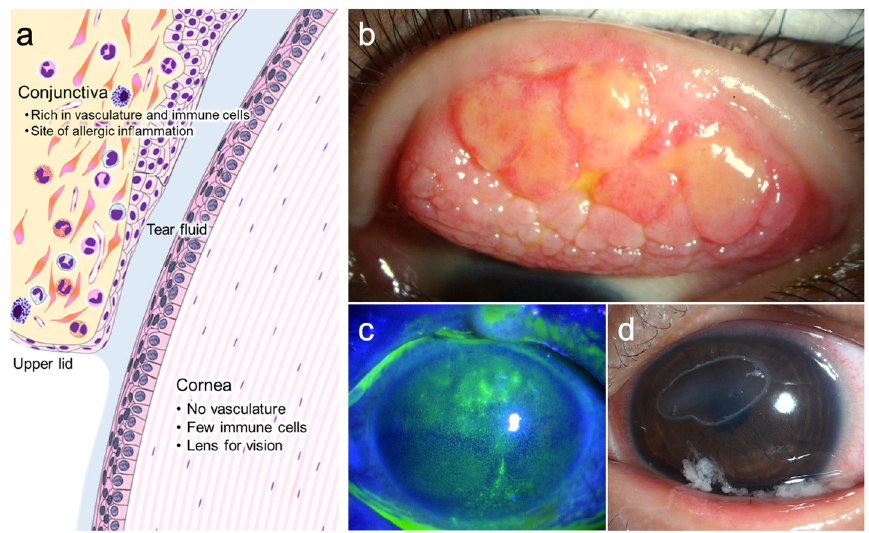
Figure 1. Anatomy of the ocular surface and clinical pictures of vernal keratoconjunctivitis (VKC). The conjunctiva and cornea lie adjacent to each other with the tear fluid ( a ). In patients with VKC, giant papillae at the upper tarsal conjunctiva ( b ) and corneal epithelial damage, such as exfoliated superficial punctate epithelial keratitis ( c ) or shield ulcer ( d ), are observed.